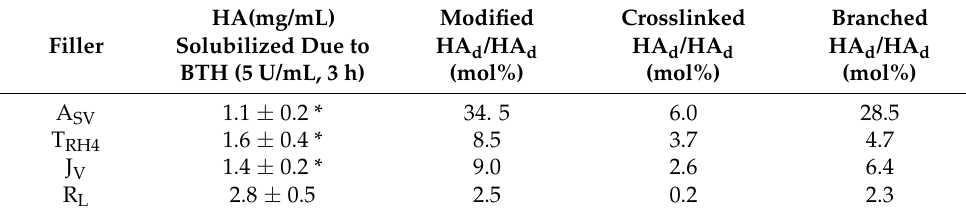
Table 2. Amount (mg/mL) of HA hydrogel solubilized due to 3 h of incubation with bovine testicular hyaluronidase (5 U/mL). The HA modification parameters derived from the NMR analyses are also reported for the sake of readability. * p > 0.05; p < 0.05 compared to A SV , T RH4 , and J V . HA(mg/mL) Filler Solubilized Due to BTH (5 U/mL, 3 h)